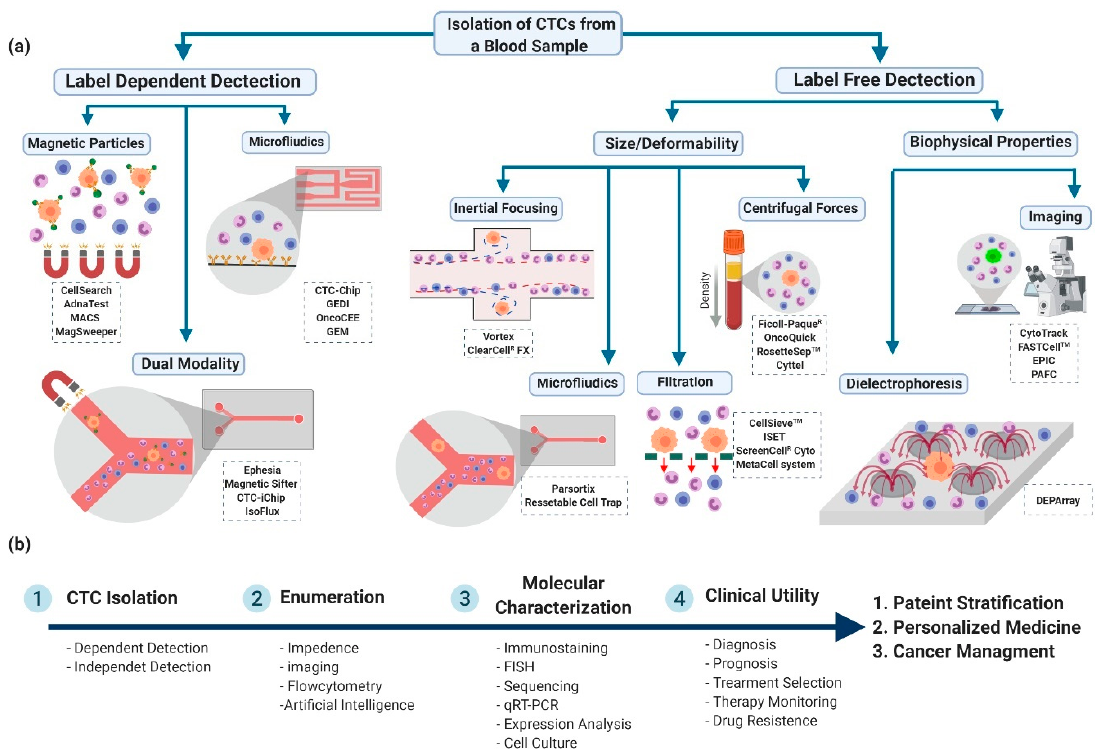
Figure 2. Schematic depicting circulating tumor cells (CTC) detection and isolation technologies. ( a ) Commercialized technologies for CTC detection, enumeration and count. CTCs can be detected based on their molecular or physical properties. Examples of commercial boxes; ( b ) illustration of CTC use as a real-time liquid biopsy after the different isolation approaches for clinical utility. Figure created with Biorender.com.